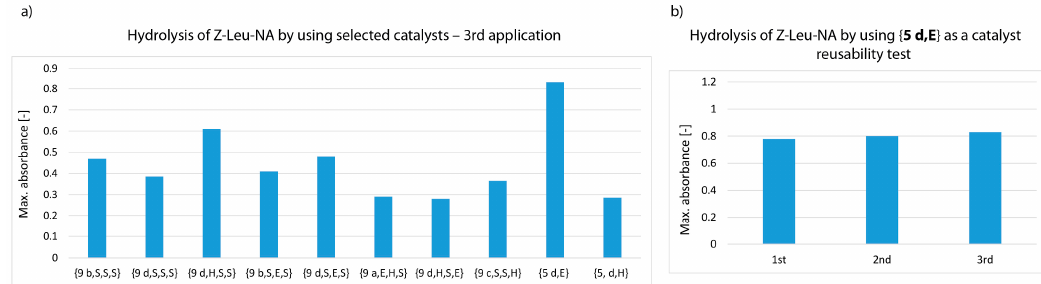
Figure 5. Measurement of Z-Leu-NA hydrolysis using the 9 most effective synzymes at pH 8.5 (third catalytic cycle, left panel a). Re-usability test of 5 d,E (panel b).